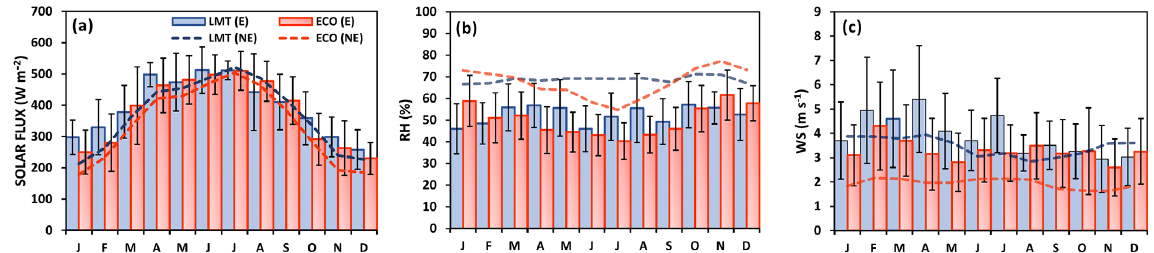
Figure 6. Monthly means of (a) solar flux, (b) relative humidity, and (c) wind speed related to event days (columns) and non-event days (dashed lines) for LMT (blue) and ECO (red). The bars indicate the standard